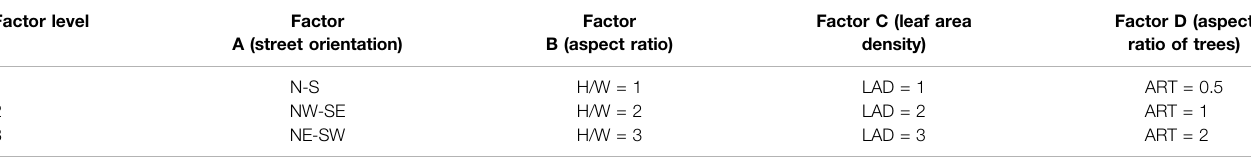
TABLE 5 | Factor levels of orthogonal models.